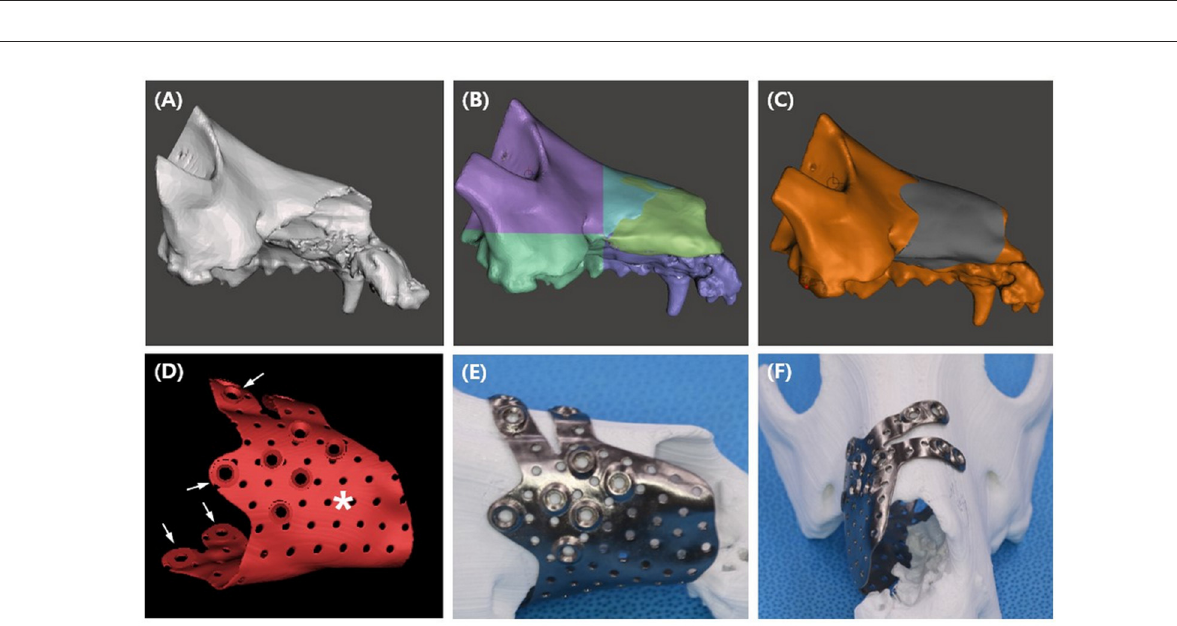
FIGURE4 PSI design procedures (A–D) , and presurgical application of the titanium PSI on the printed PLA bone. STL file of the maxilla (A) was sectioned to smaller parts (B) , mirroring of the left maxilla reconstructed the right maxilla (yellow green area). Implant shape was offset from the bone (C) , multiple pores and 2.4 cortical screw holes were added to the design (D) . Finger parts of the design (arrow) allows the PSI to snap fit to the bone, the palm part (asterisk) covers the bone defect. After receiving the titanium implant, simulation of the implant was performed on a PLA printed bone model (E,F)